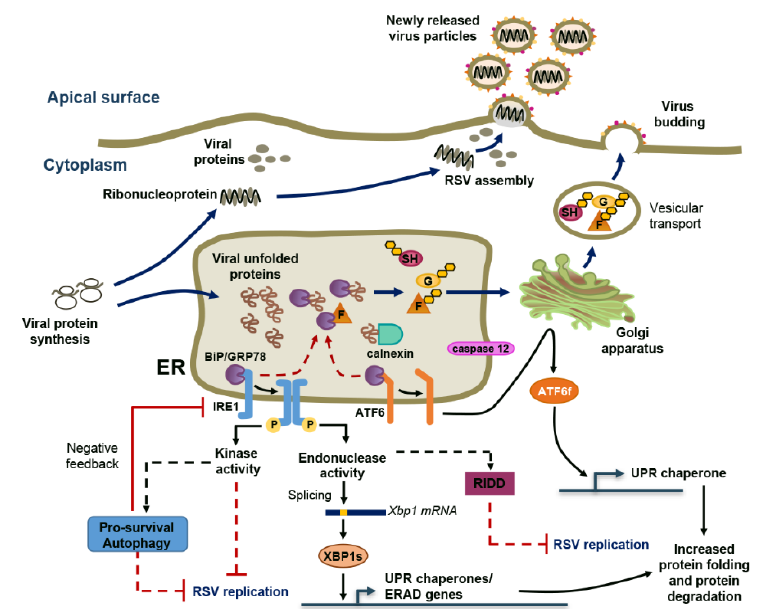
Figure 1. RSV Induces a Non-Canonical UPR Response. Endoplasmic Reticulum (ER) stress induction upon Respiratory Syncytial Virus (RSV) infection, possibly as a result of ER overload due to glycoprotein RSV F, G and SH transit, is associated with activation of the inositol-requiring enzyme 1 (IRE1) and activated transcription factor 6 (ATF6) branches of the unfolded protein response (UPR). Interaction of F with the binding immunoglobulin protein (BiP/GRP78) chaperone could be an initiating event of the UPR response. Increased protein folding and degradation capacity are induced as a result of X-box binding protein 1 (XBP1) splicing variant XBP1s production by IRE1 endonuclease activity and ATF6f fragment formation. IRE1 acts as a restriction factor against RSV independently of XBP1s. IRE1 kinase activity and IRE1-endonuclease activity involved in selective mRNA degradation, a process called IRE1-dependent decay (RIDD), might contribute to IRE1-dependent inhibition of RSV replication through mechanisms that remain to be characterized. Autophagy was shown to promote negative feedback on the IRE1 pathway.